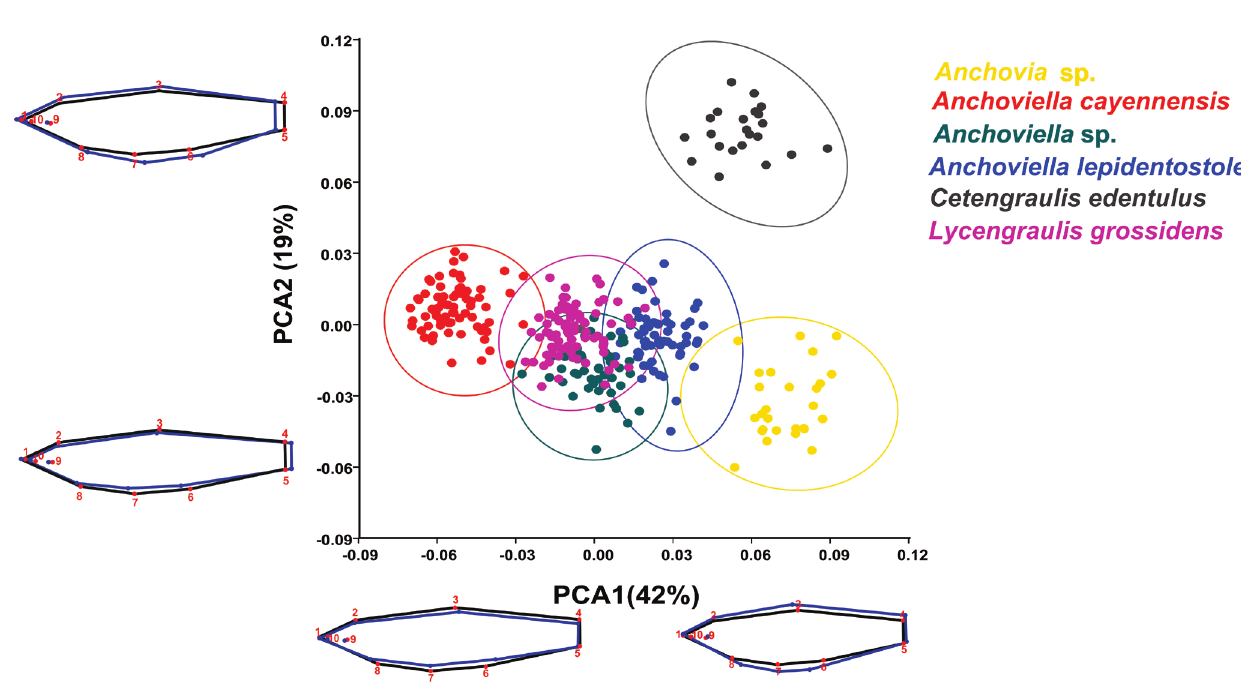
FIGURE 4 | Principal Components Analysis indicating the visual ordination of the six species of pilombetas in the morphospace. Estimated changes in dorsal and ventral view shape are shown as deformations from the mean shape along the first and second principal components.